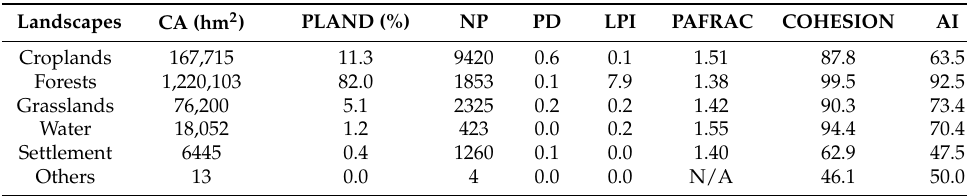
Table 3. Index statistics of the patch scales in